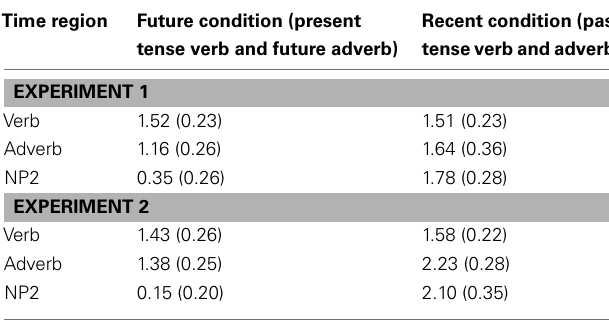
(future target)) as a function of condition and time region for Experiment 1 and